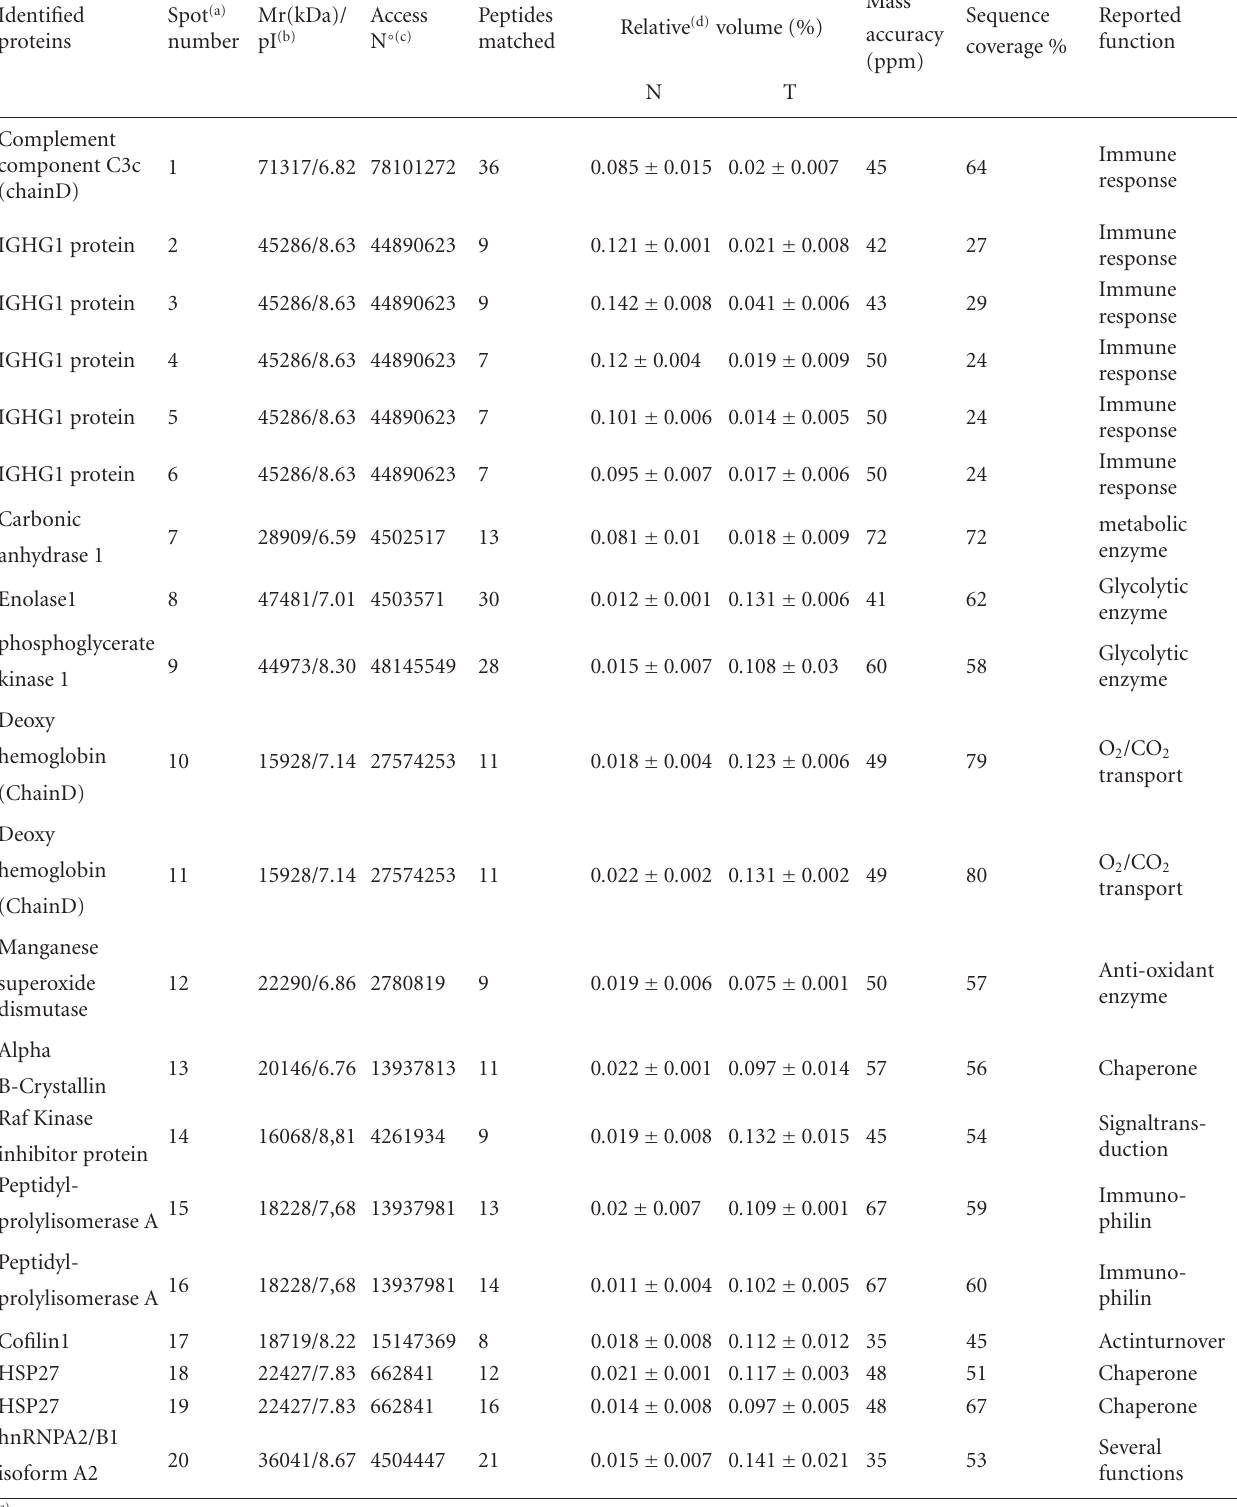
Table 1: Results of MALDI-TOF mass spectra and database searching for protein